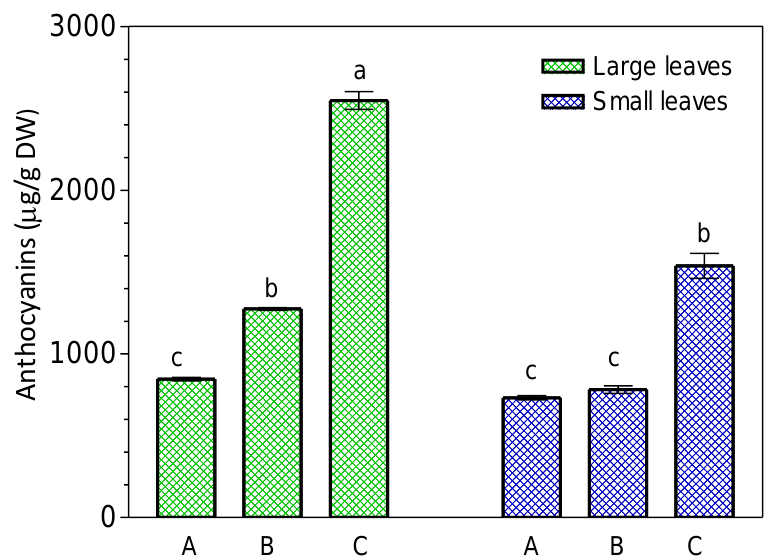
Figure 7. Anthocyanin content in K. blossfeldiana leaves on the plant (A) and in the detached leaves kept 4-day in the normal position (B) or kept 4-day in the inverted position (C). Mean results ± standard deviation followed by the same lower letter were not significantly different ( p < 0.05) according to Tukey’s test.